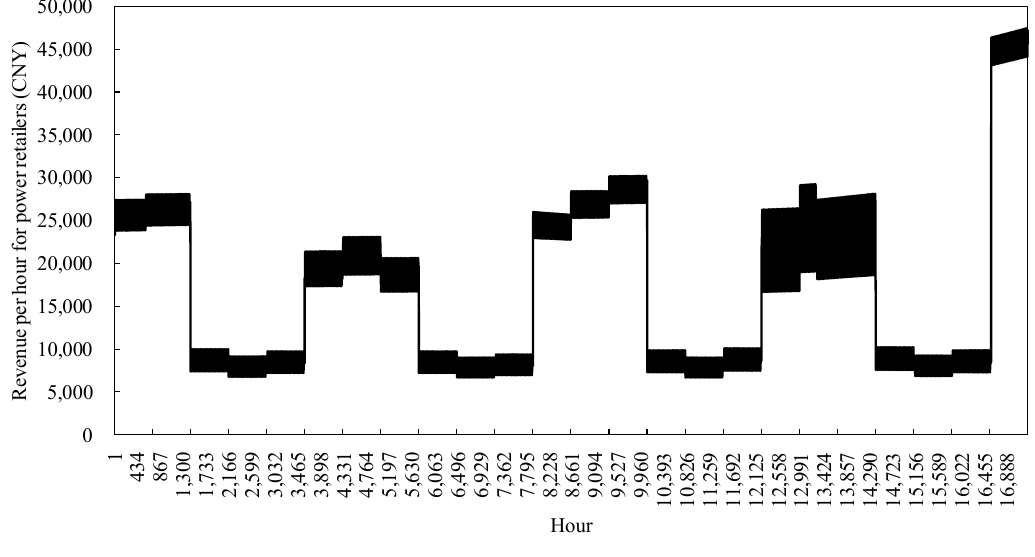
Figure 13. Earnings of power retailers.